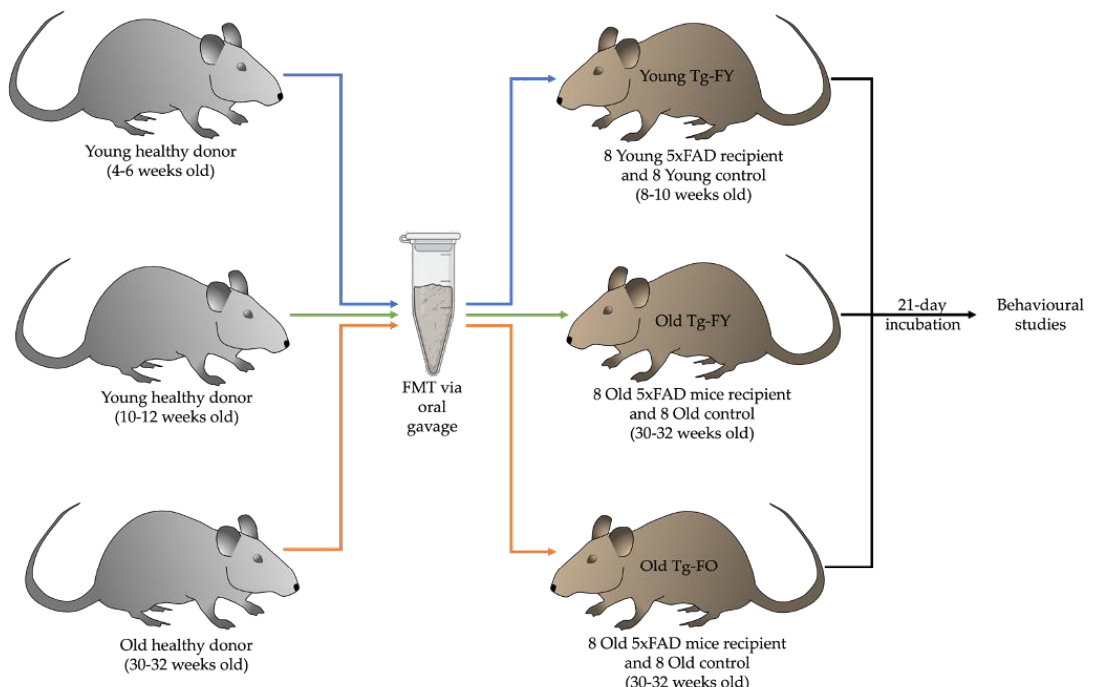
Figure 1. Diagram showing treatment and numbers of healthy (WT) and transgenic mice undergoing FMT via oral gavage. Young Tg-FY: Young Transgenic-Fed Young, Old Tg-FY: Old Transgenic-Fed Young, Old Tg-FO: Old Transgenic-Fed Old.